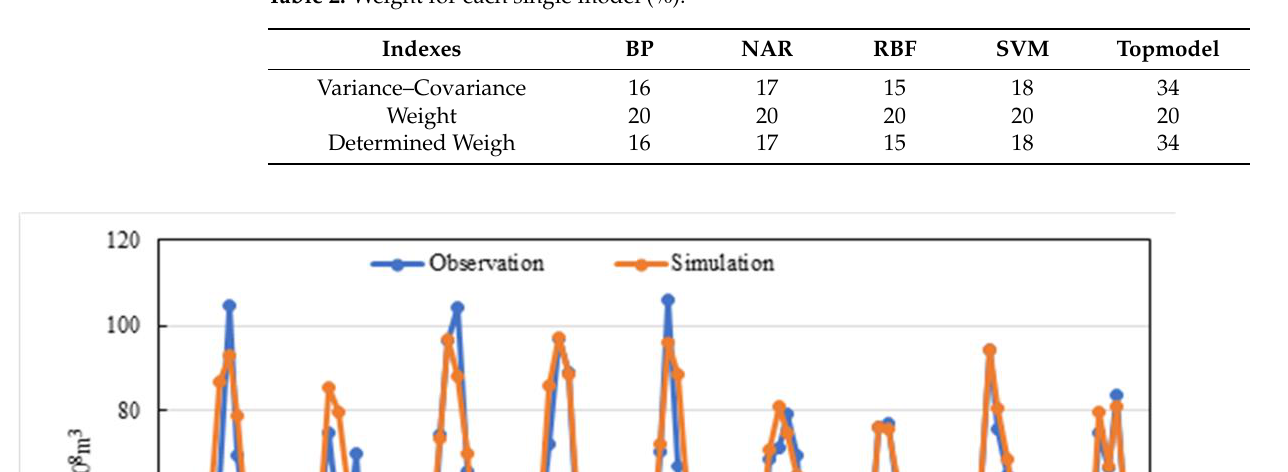
Table 2. Weight for each single model (%).